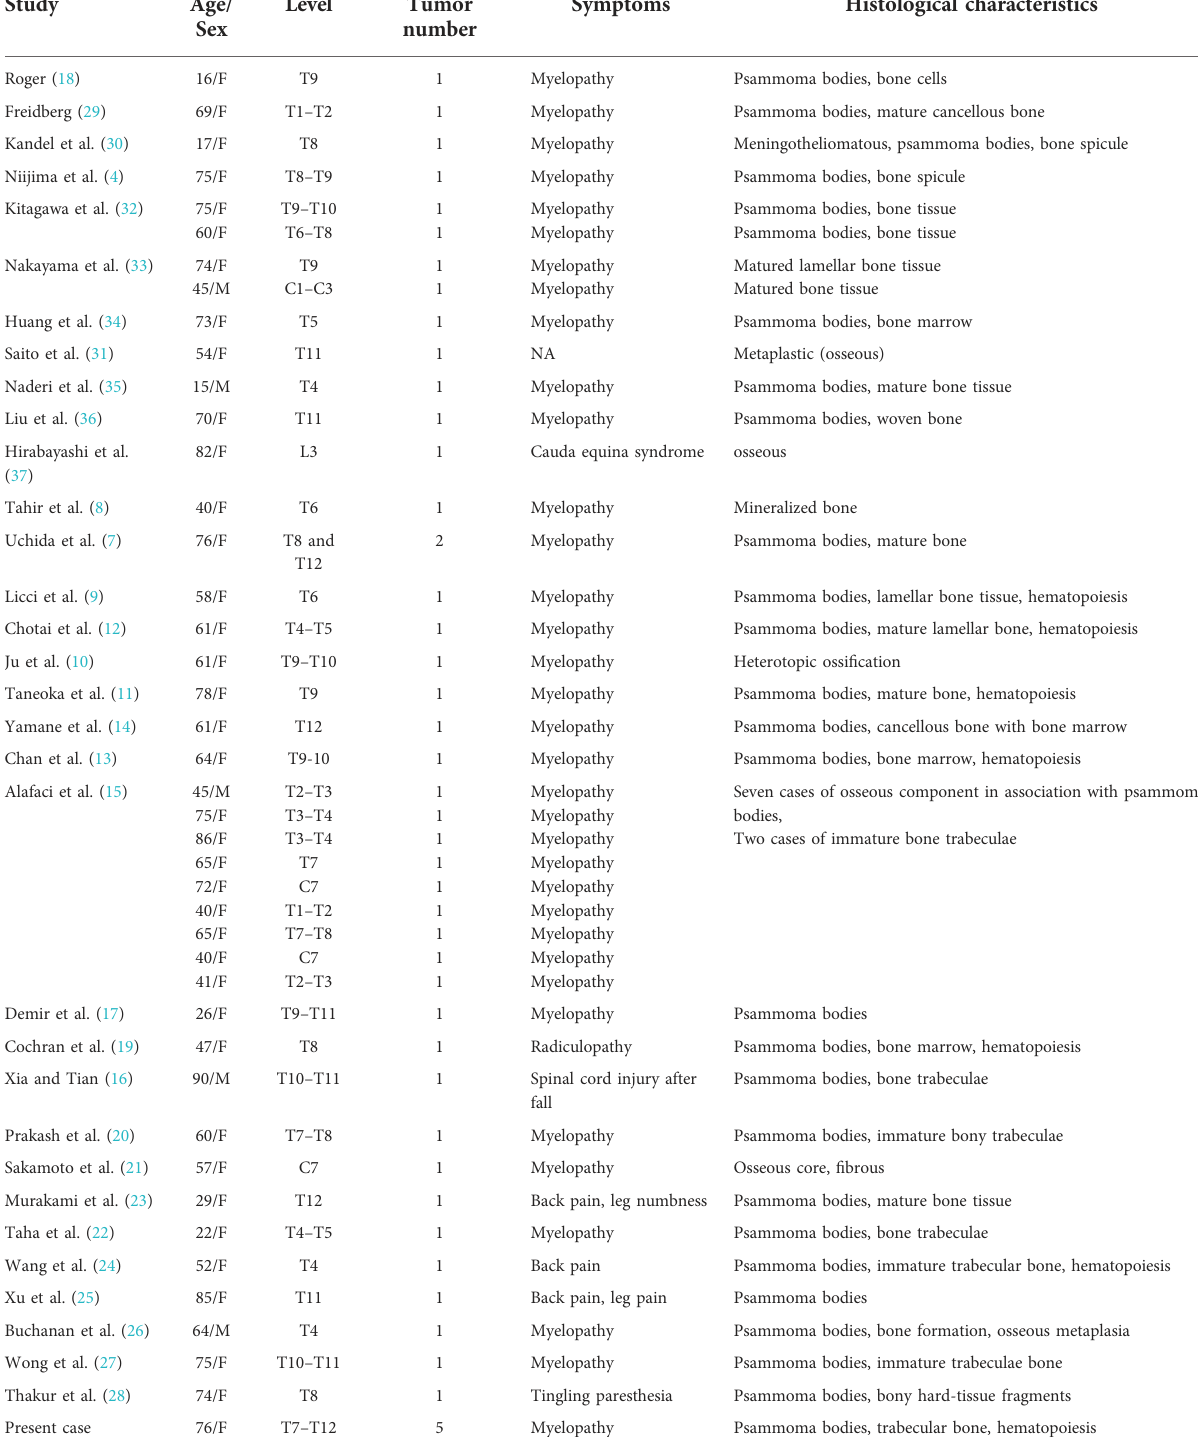
TABLE 1 Summary of ossi fi ed meningioma